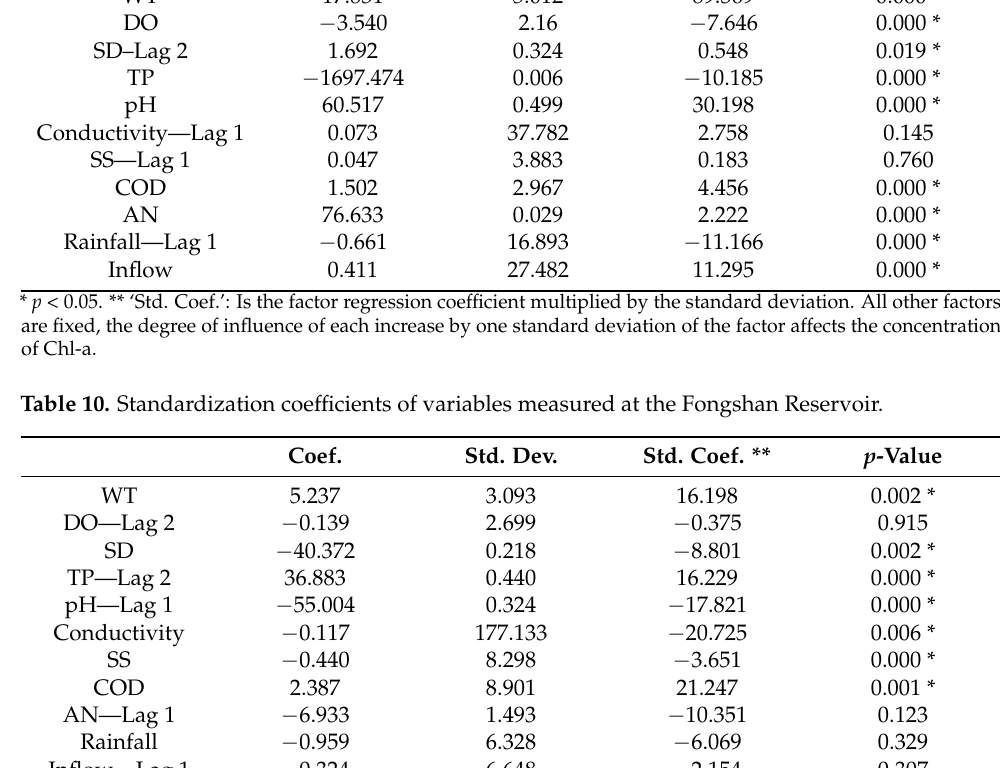
Table 9. Standardization coefficients of variables measured at the Mingde Reservoir. Coef. Std. Dev. Std. Coef. **